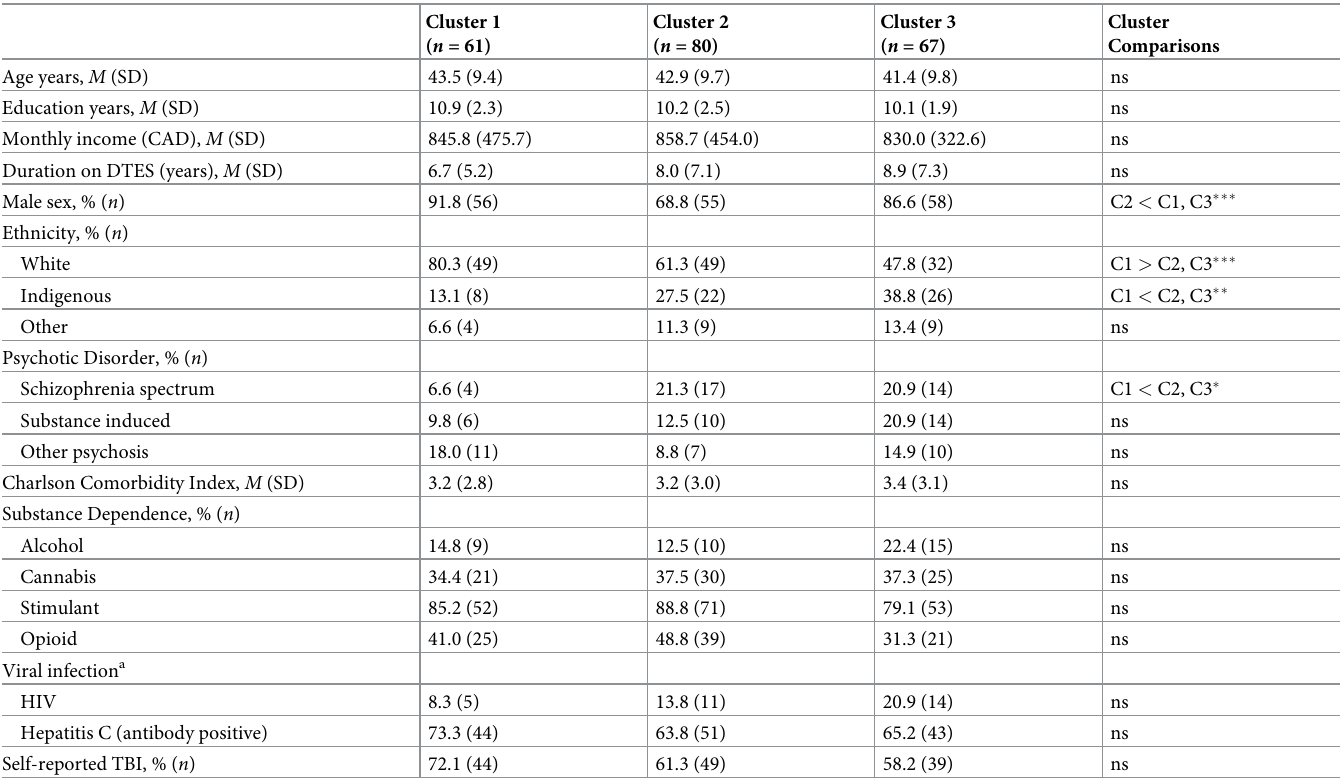
Table 1. Neurocognitive cluster